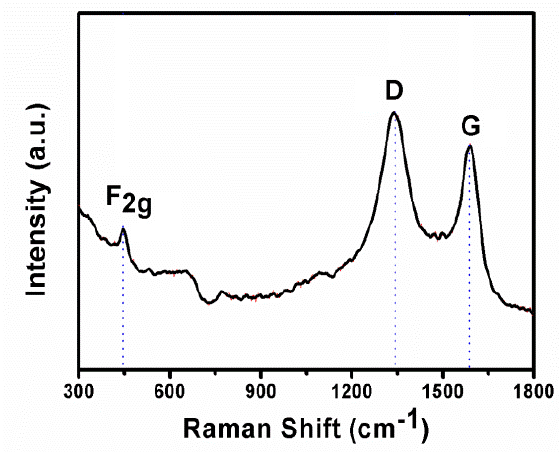
Figure 3. Raman spectra obtained from CeO 2 /RGO composites.